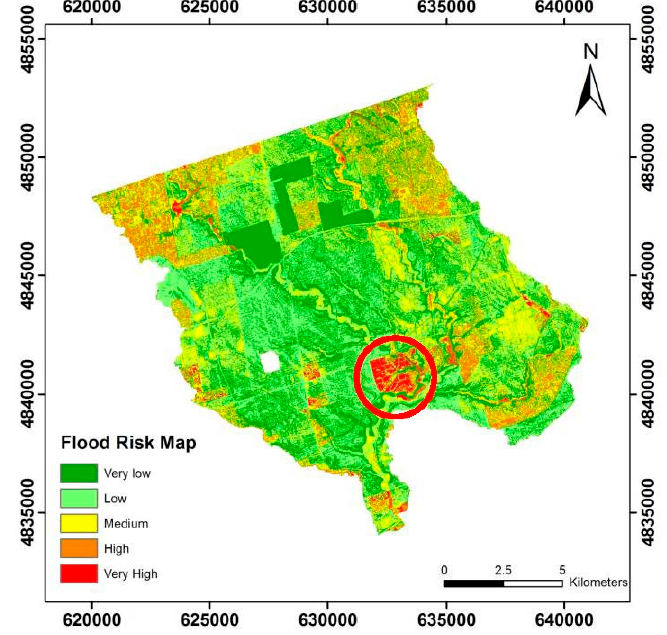
Figure 9. Flood Risk map based on total flood hazard and total vulnerability. Note: In the upper region of the map, there are three distinct (green) polygon regions characterized with very low risk due to lack of data. The circular red marker indicates a validation area.